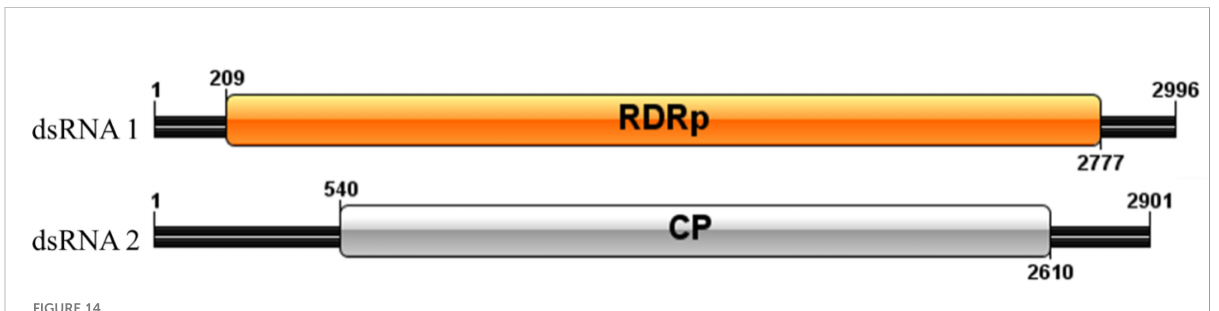
FIGURE 14 Diagrammatic representation of the genome organization of PvVV L1.